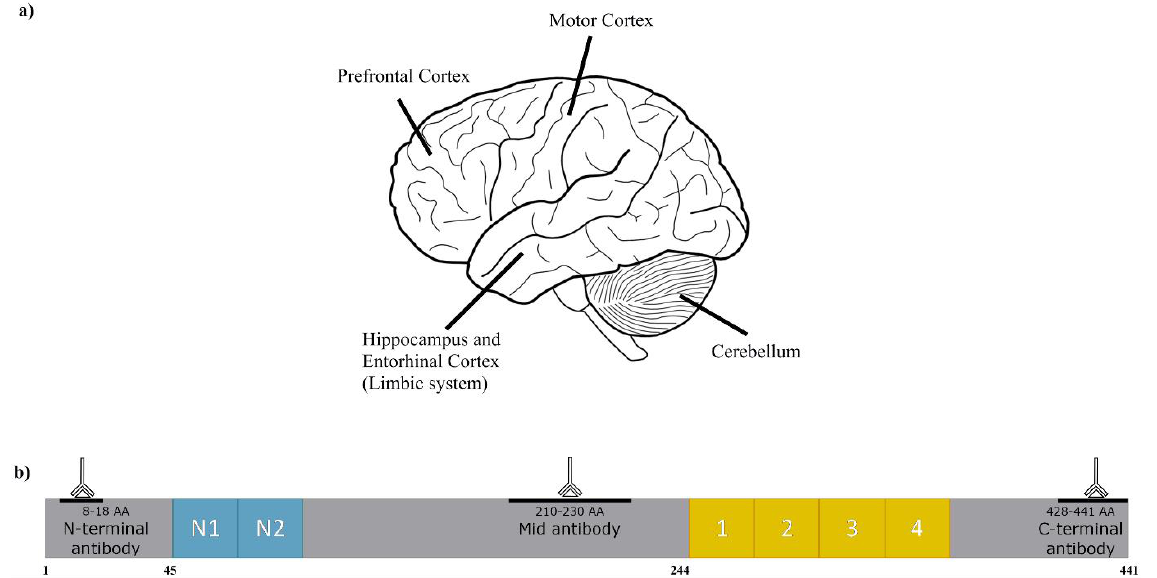
Figure 1. Schematic of the brain regions examined, and the antibodies used to probe Tau. ( a ) Diagrammatic representation of the human brain with the regions highlighted. As illustrated, both the hippocampus and entorhinal cortex are internal. ( b ) Schematic of the Tau 441 isoform with highlighted antibody epitope recognition sites.